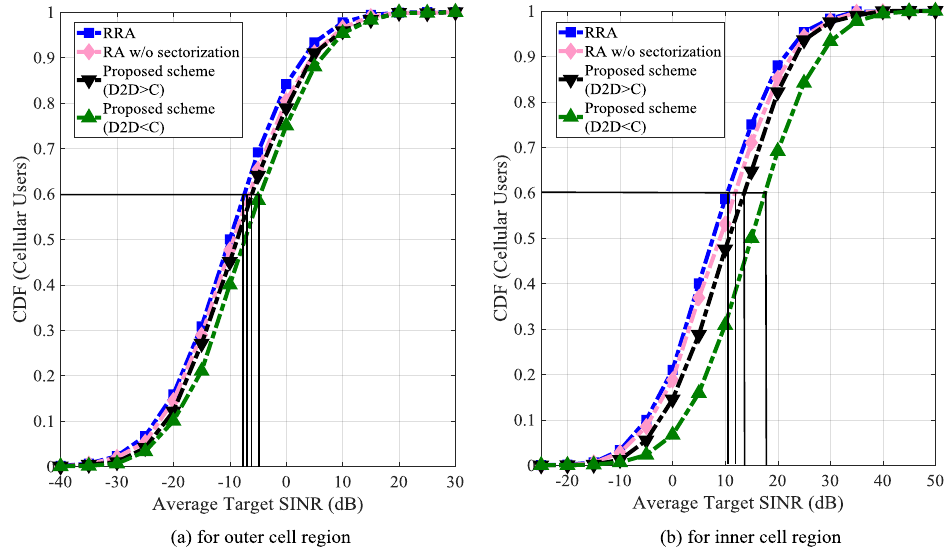
Figure 6. Average target SINR vs. CDF for cellular users, ( a ) outer cell region, ( b ) inner cell region.